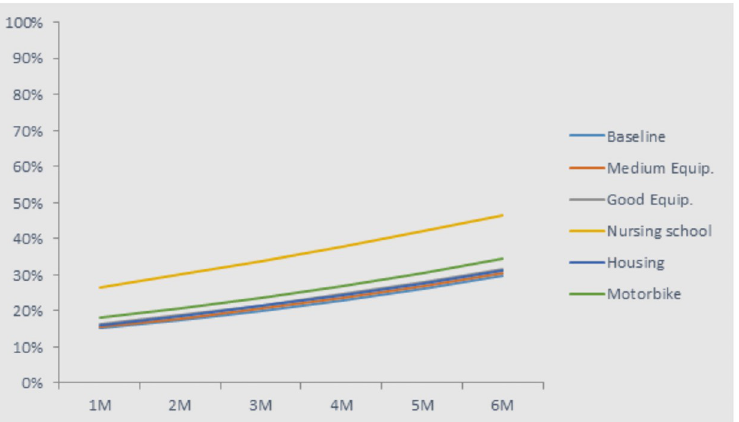
Fig 8. Uptake rate of jobs in rural health posts for